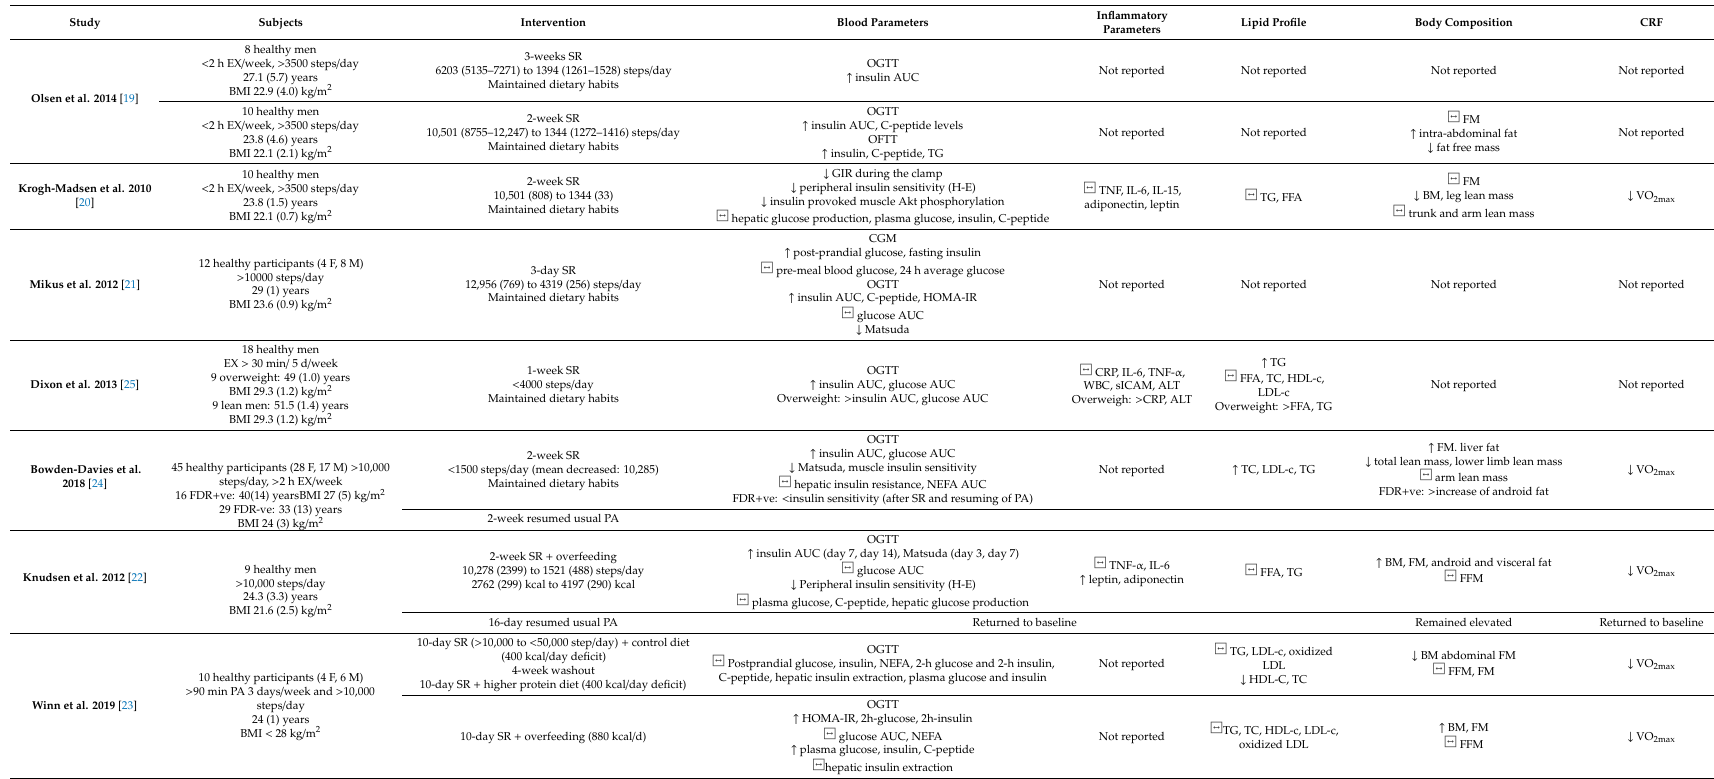
Table 1. Summary of the studies reviewed examining the e ff ects of acute physical inactivity and / or overfeeding.